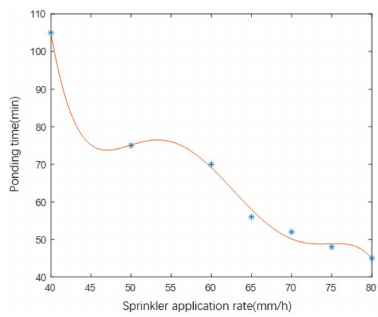
Figure 6. The relationship between application rate of sprinkler irrigation and the duration of water accumulation. * is the data points of the finite element simulation, the red line is fitted through the data points.